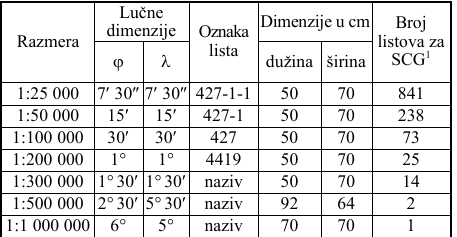
Topografske i preglednotopografske karte u